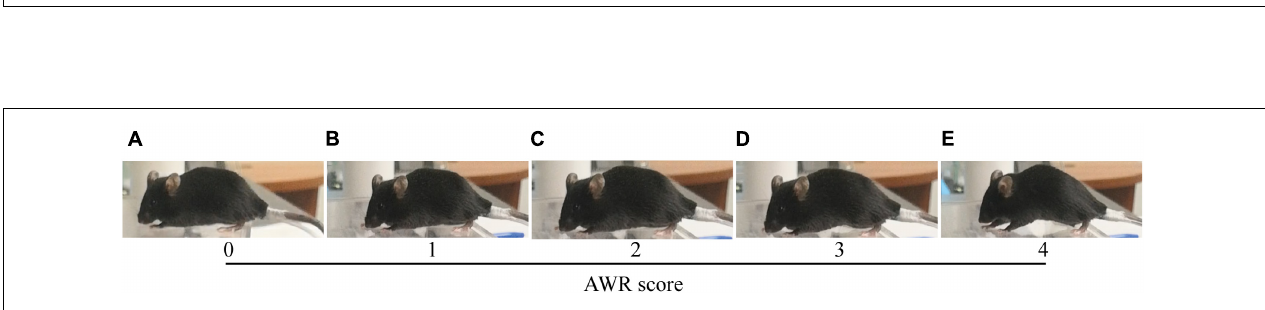
FIGURE 2 | Novel and small size distention balloon. (A) Teflon tube with 1 mm outer diameter, 0.6 mm internal diameter. (B–D) The distention balloon was made from a little finger of a small size latex glove (2 cm in length) placed into Teflon tubes and were tied with 6-0 silk thread at a distance of 1, 1.5, and 2 cm, respectively, from the tip of the glove finger. The balloon was about 3 mm in diameter, 1 cm long, and was subsequently sealed using parafilm in a manner of winding at a distance of 2 cm from the tip of the glove finger. (E) Pressure gauge, 10-ml syringes, and distention balloon (from left to right). (F) Pressure gauge shows the distention balloon working at a pressure of 80 mmHg. (G–N) Sizes of distention balloon at 10–80 mmHg pressure.